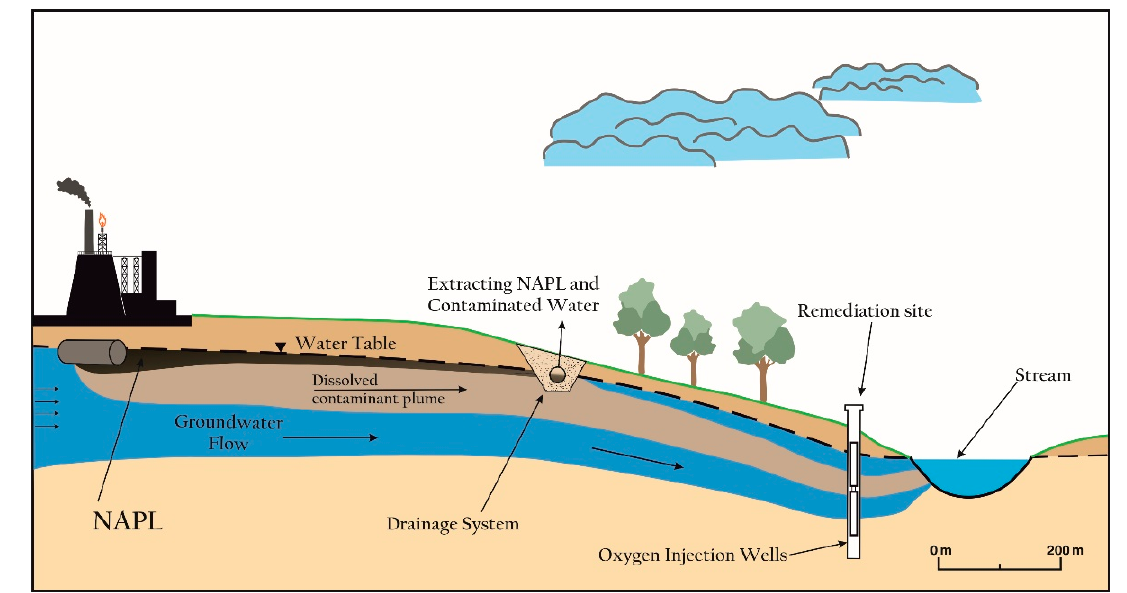
Figure 1. Concept view of contaminant transport in groundwater at test site.